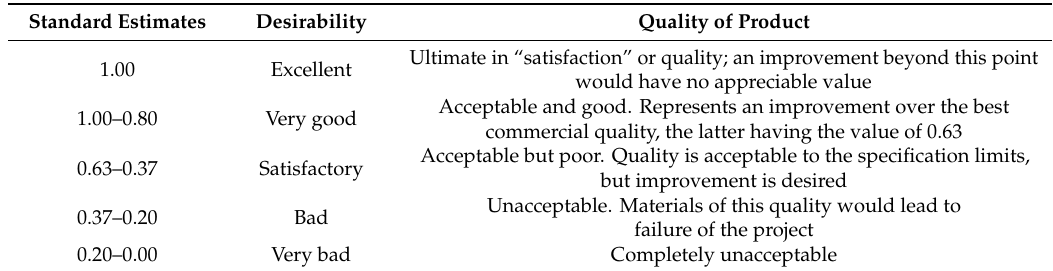
Table 16. Qualitative evaluation of desirability function [46,74].